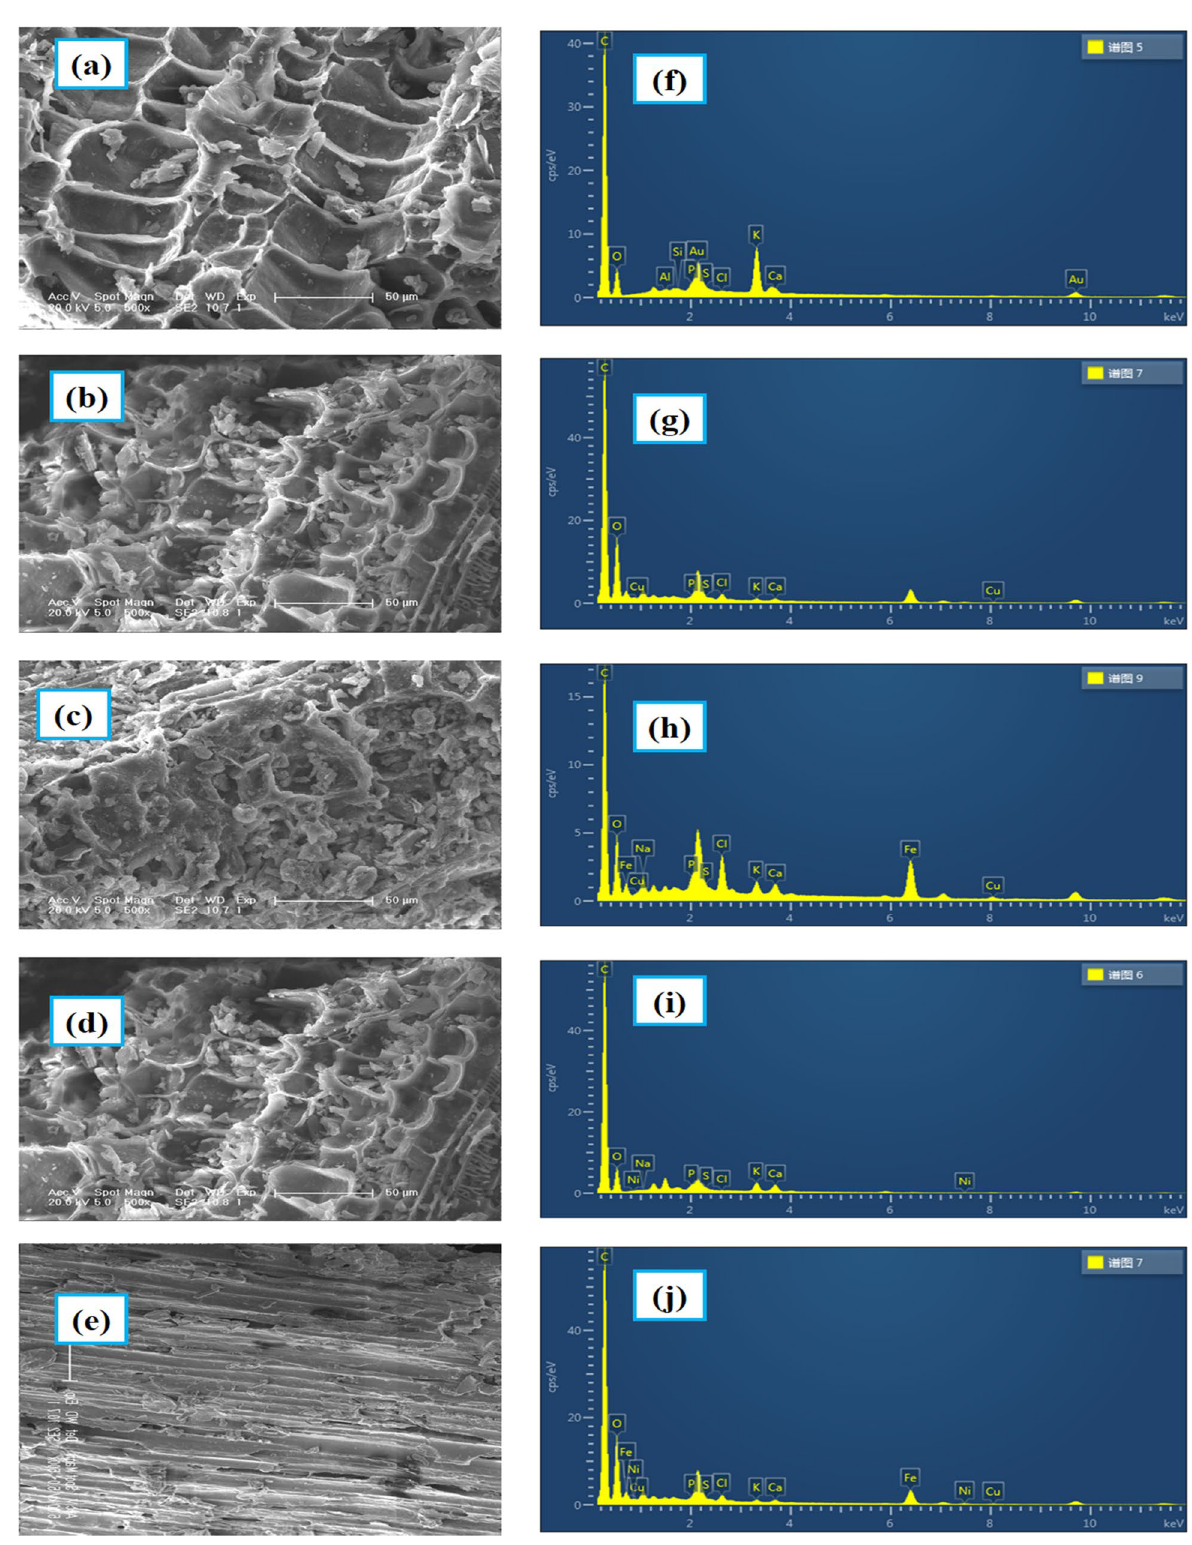
Figure 2. ( a ) SEM image of AGWTR before adsorption, ( b ) SEM image of AGWTR after adsorption of Cu 2+ , ( c ) SEM image of AGWTR after ADS/EC of Cu 2+ , ( d ) SEM image of AGWTR after adsorption of Ni 2+ , ( e